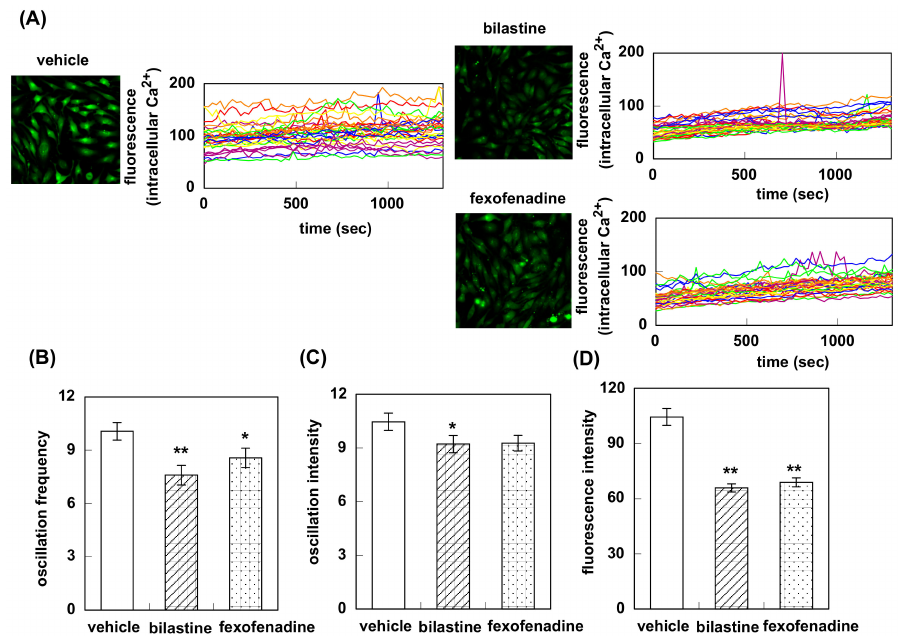
Figure 2. E ff ect of bilastine and fexofenadine on intracellular Ca 2 + elevation in response to the constitutive activation of histamine H 1 receptor. ( A ) HeLa cells were treated with 10 µ M of bilastine or fexofenadine for 2 h at 37 ◦ C and intracellular Ca 2 + was monitored for 20 min at 22 sec intervals. In ( B ) to ( C ), oscillation frequency ( B ), oscillation intensity ( C ), and fluorescence intensity ( D ) for 20 min were counted. Data are expressed as means ± SEM ( n = 30). **, p < 0.01; *, p < 0.05 vs. vehicle.